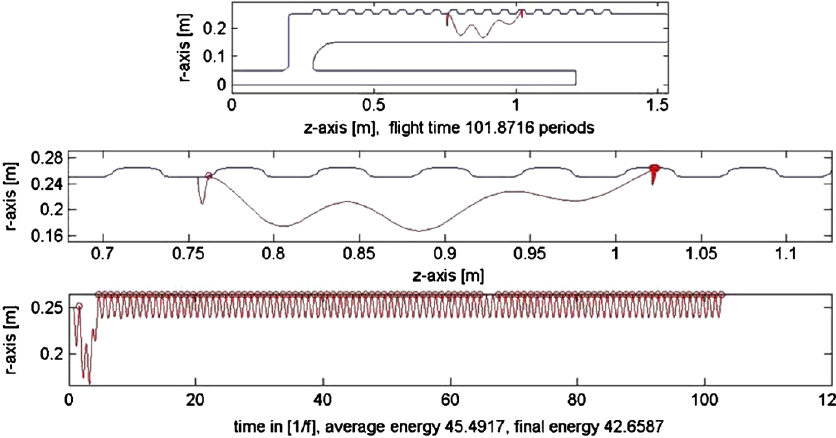
FIG. 14. (Color) Stable trajectories of electrons inside a 3 cm wide